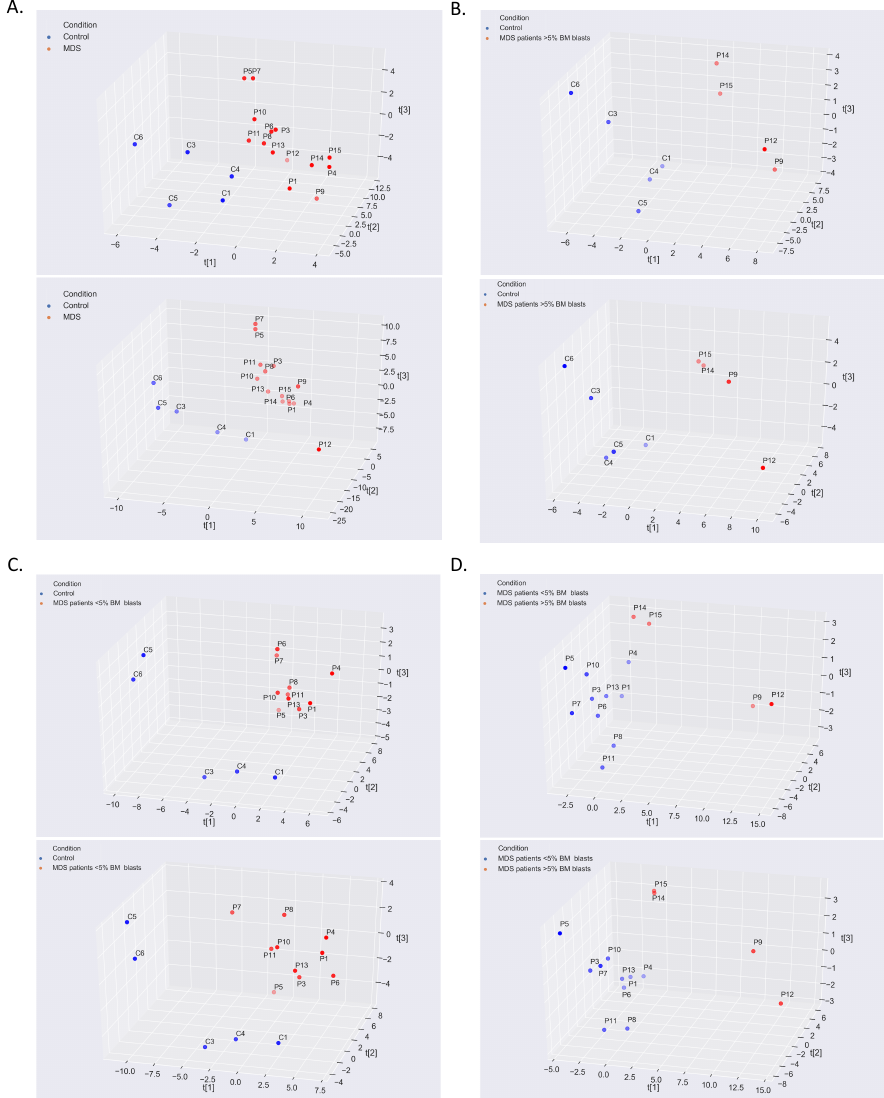
Figure 1. Myelodysplastic syndrome (MDS) metabotypes indicate distinct clusters for patients Figure 2. Modulation of metabolites in MDS myeloid cells compared to controls per metabolic pathway. (A)The Warburg effect by means of each immediate branching pathways (B) Sphingolipid and Phospholipid Metabolism (C)Nitrogen Recycling and Reductive Carboxylation (D)One Carbin Transfer Metabolism (E)Nicotinate and Nicotinamide Metabolism. Data were processed using MetaboKit